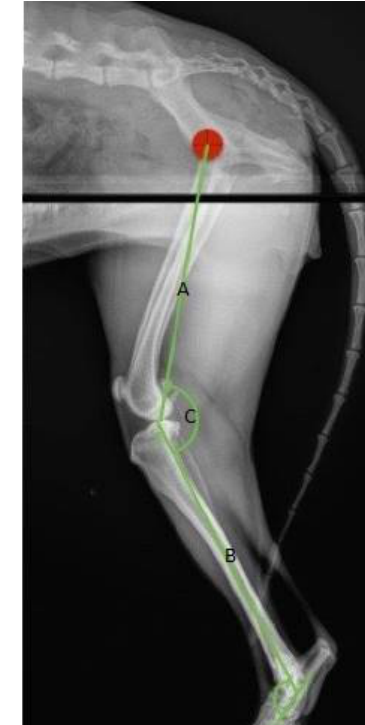
Table 1. Breed, weight, femorotibial angles, tibiotarsal angles and tibial plateau angles.